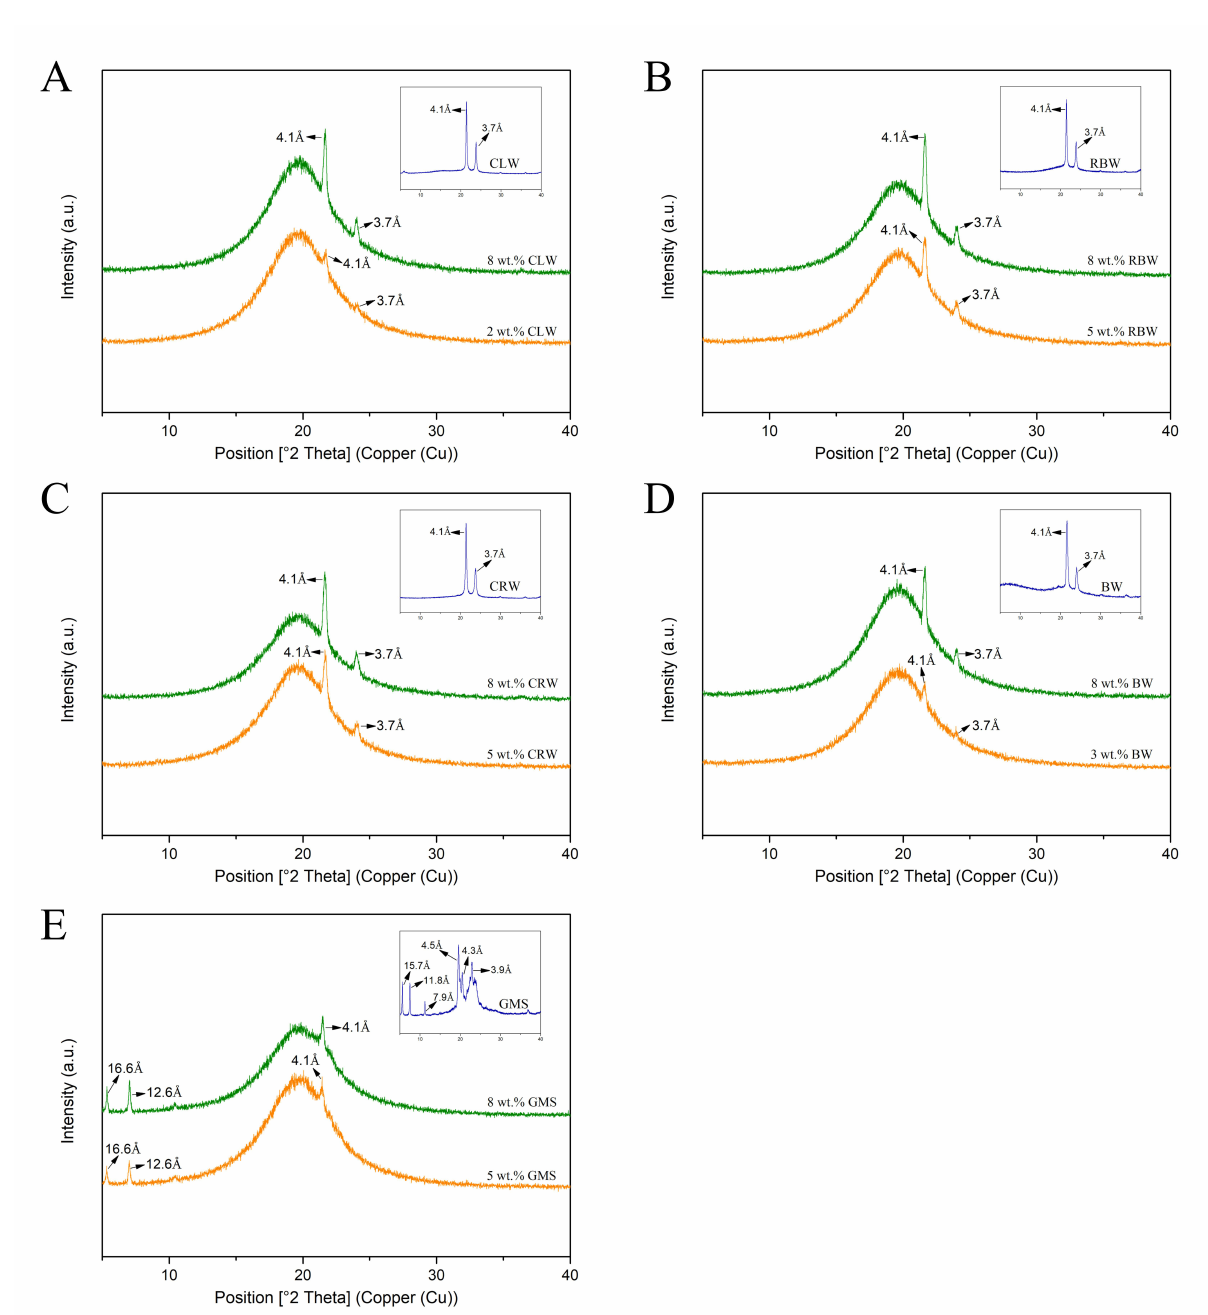
Figure 5. The X-ray diffractograms of oleogels formed by different gel factors at critical and 8 wt.% concentrations, ( A ) CLW oleogels; ( B ) RBW oleogels; ( C ) CRW oleogels; ( D ) BW oleogels; ( E ) GMS